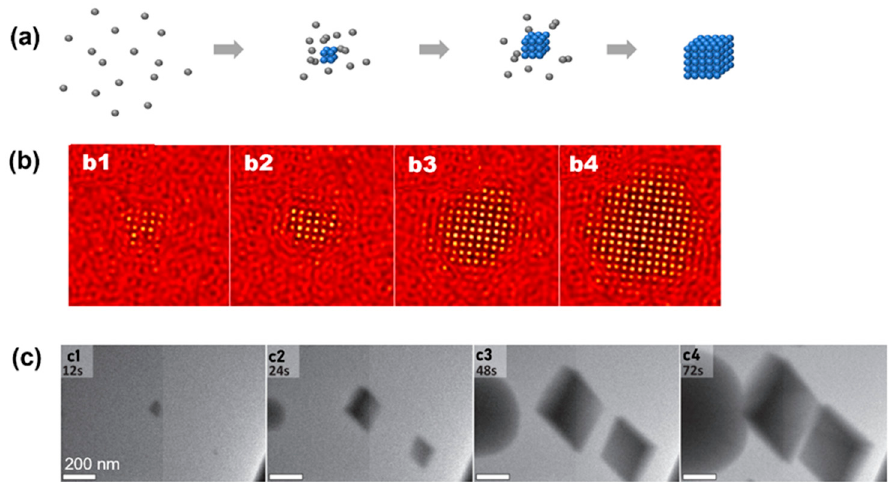
Figure 2. Simulation and experimental observations of the classical nucleation pathway: ( a ) Schematics illustrating the crystallization pathway following classical nucleation theory. ( b ) Simulation snapshots showing crystallization following classical nucleation theory. From ( b1 ) to ( b4 ), it shows the temporal evolution of crystal nuclei in computer simulation. Reproduced with permission from Ref. [35]. Copyright 2016 American Chemical Society. ( c ) Liquid-phase TEM snapshots of vaterite particles forming and directly nucleating from the solution following classical nucleation theory. From ( c1 ) to ( c4 ), the temporal evolution of the nuclei are captured by liquid-phase TEM. Reproduced